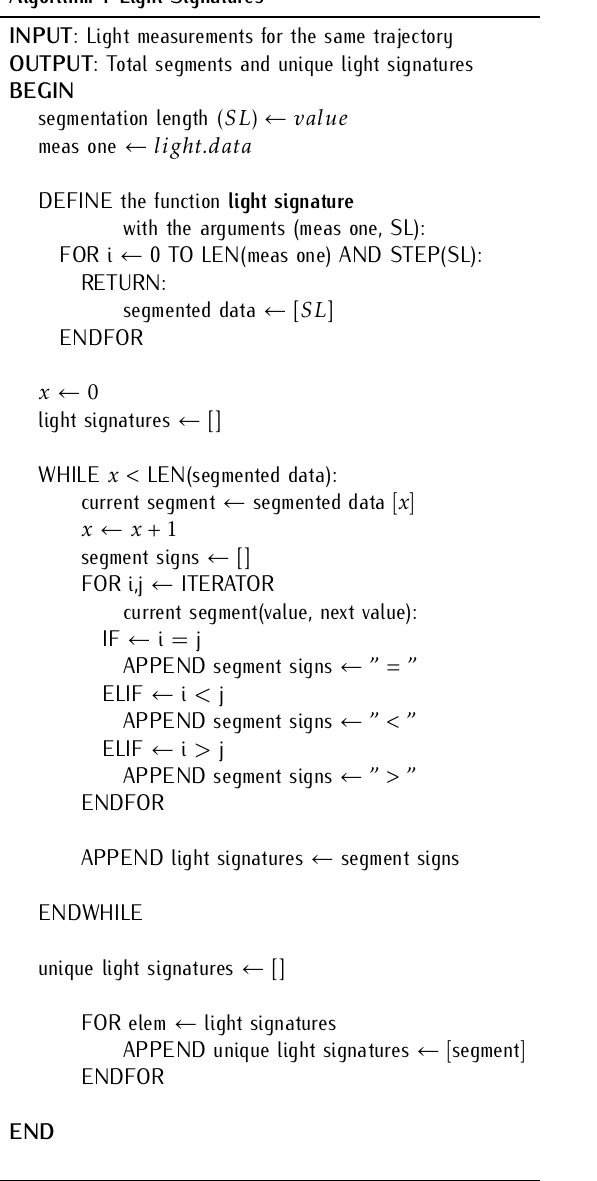
Algorithm 1 Light Signatures Algorithm 2 Light